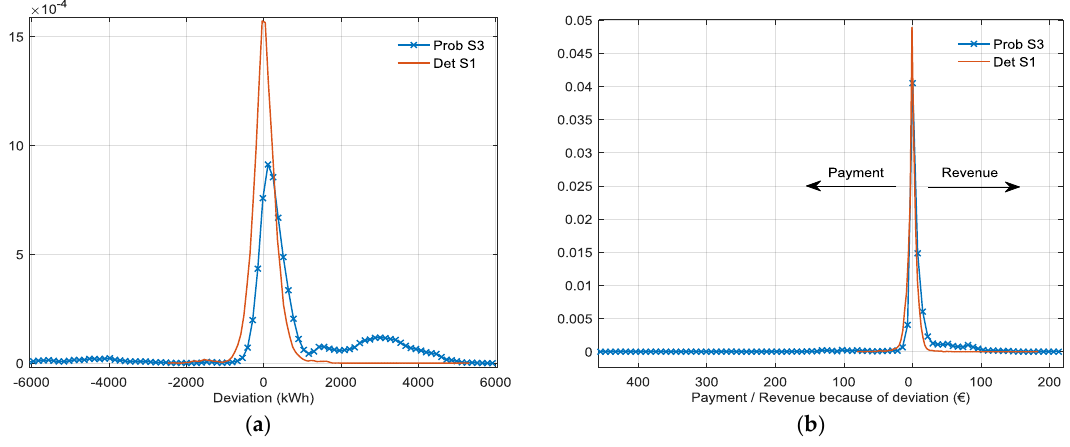
Figure 7. ( a ) PDF of the energy deviation after the intraday market; ( b ) PDF of the payment/revenue due to deviation after the intraday market.